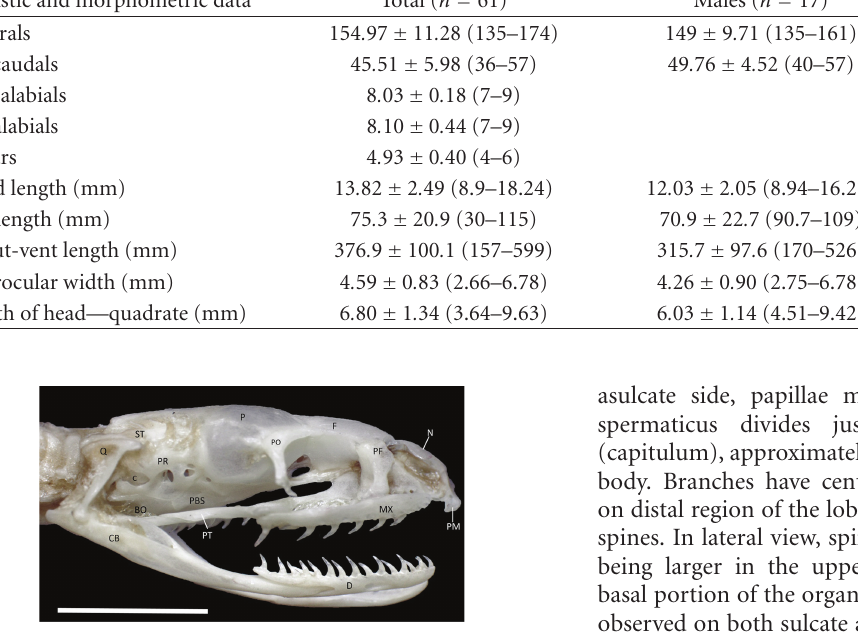
Figure 5: Lateral view of the skull of Sordellina punctata (IBSP 62809). Bar = 5 mm. Abbreviations other than in previous